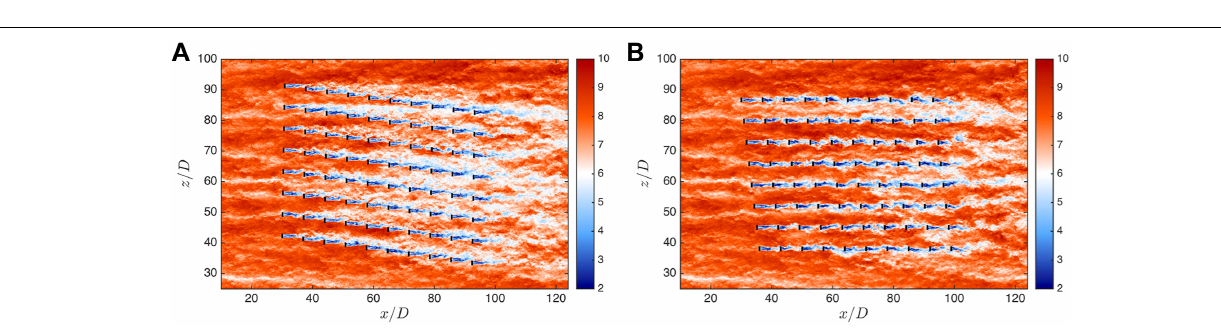
FIGURE 3 | Instantaneous streamwise velocity on a horizontal plane at hub height for the wind directions α w = 262 ° (A) and α w = 270 ° (B) . The units are in